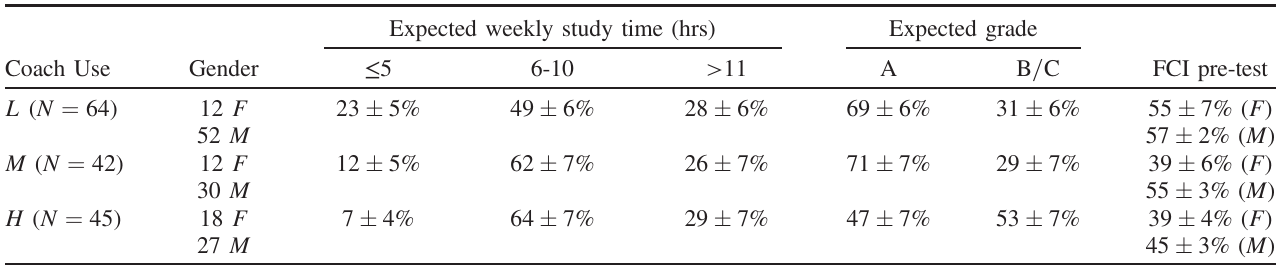
TABLE VII. Characteristics of students in the low ( L ), medium ( M ), and high ( H ) coach use groups from a background and expectations survey and the FCI administered during the first week of the spring 2013 semester. Expected weekly study time (hrs) Expected grade Coach Use